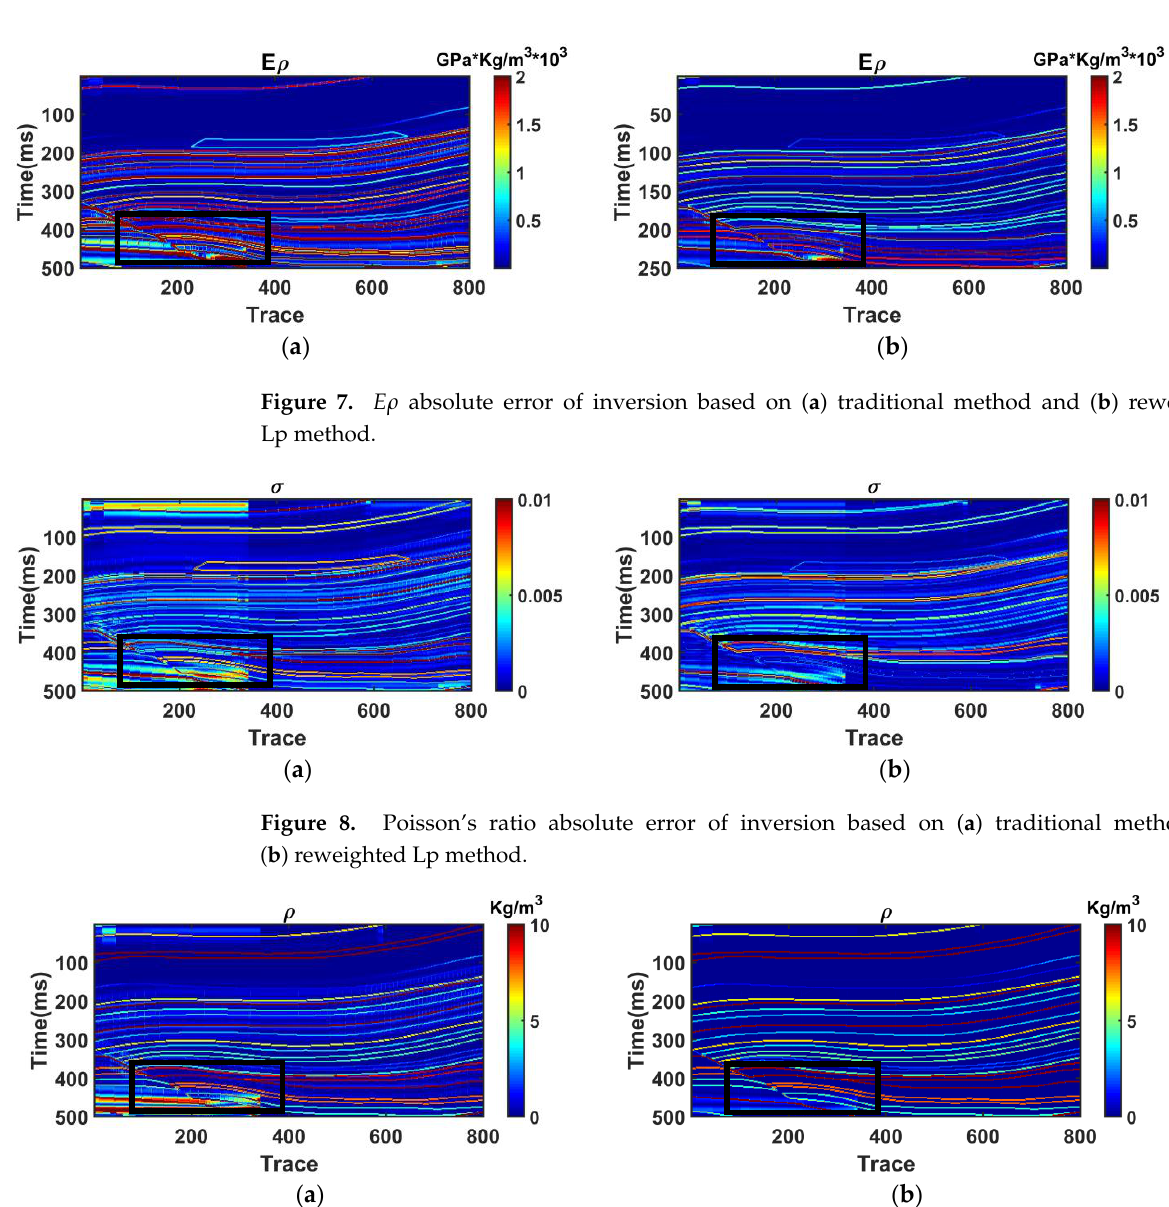
Figure 9. Density absolute error of inversion based on (a) traditional method and (b) reweighted Lp method.